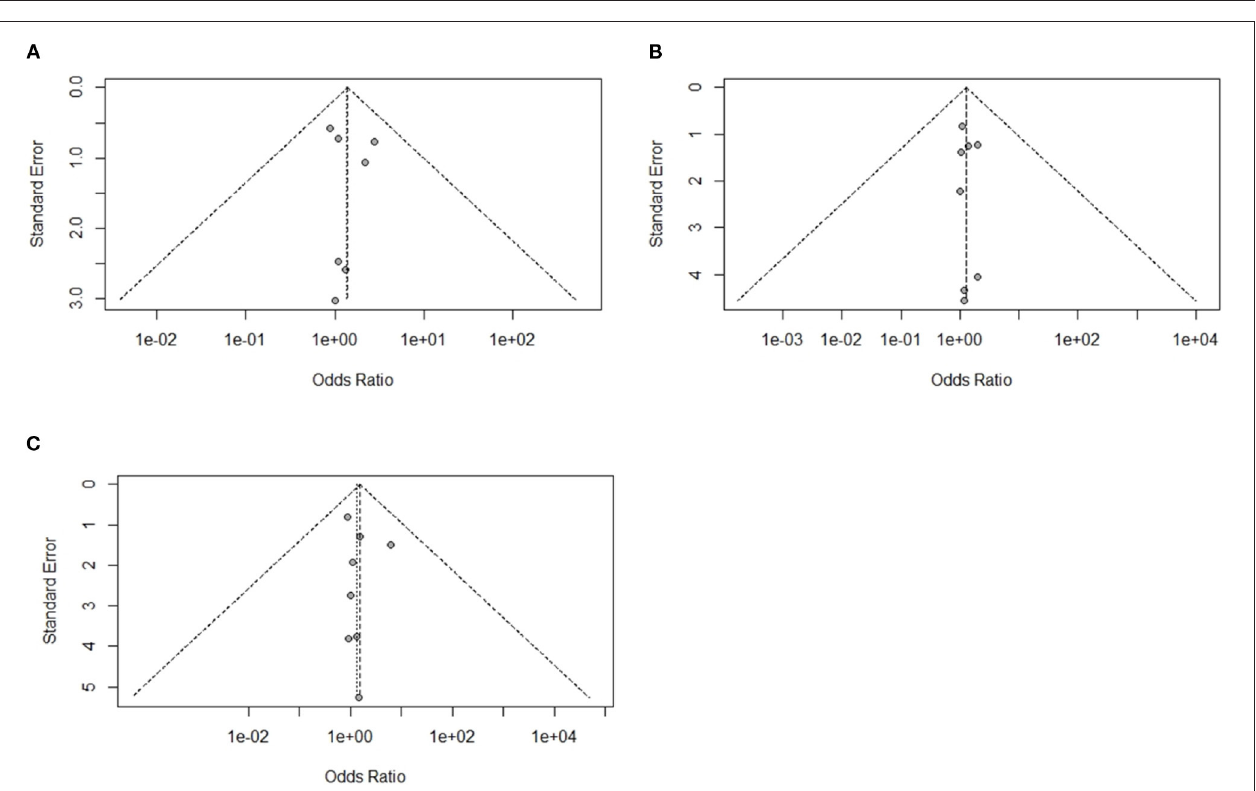
FIGURE 3 | Funnel plots representing the effect of heat stress on immune organ mass journal publication bias. (A) Symmetric funnel plot consistent with lower likelihood of publication bias of our selected thymus related journal, (B) symmetric funnel plot consistent with lower likelihood of publication bias of our selected spleen related journal, and (C) symmetric funnel plot consistent with lower likelihood of publication bias of our selected bursa of Fabricius related journal.